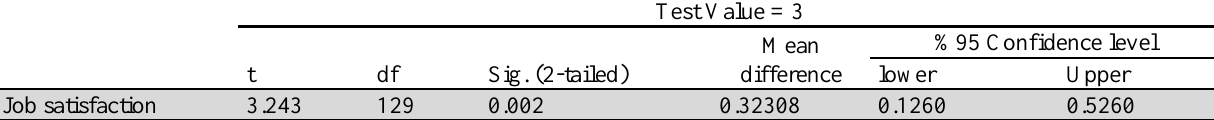
The results of t-student test on the level of job satisfaction for high-risk